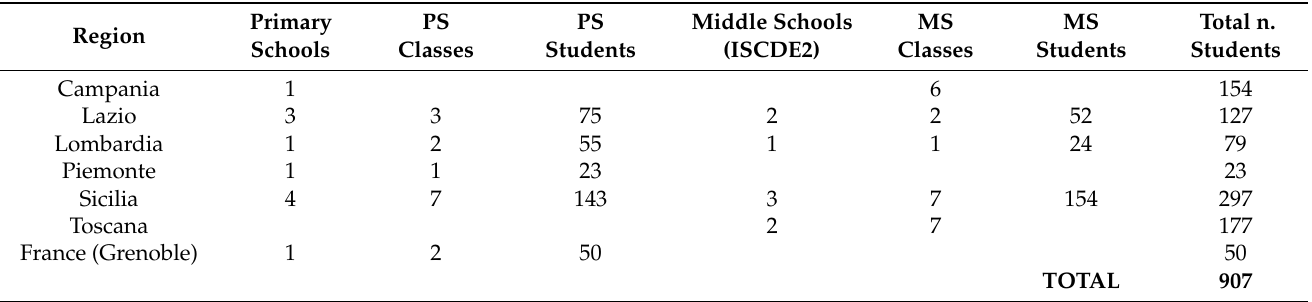
Table 2. Schools involved in the Salvina and the earthquake educational online gaming experience.